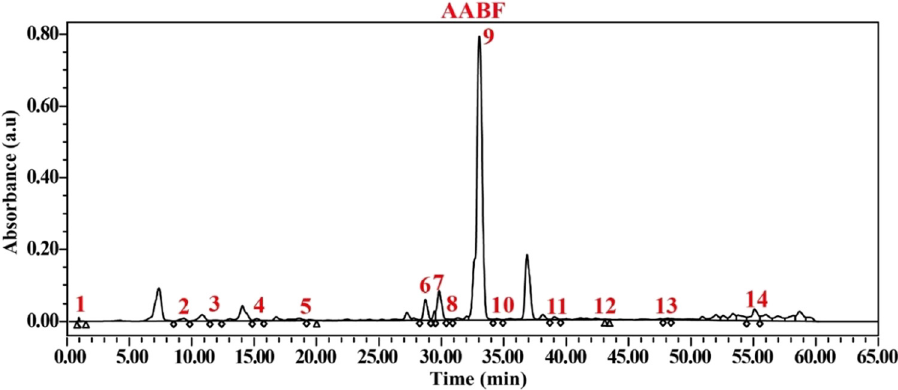
Figure 5: HPLC chromatogram of AABF. Peaks showing similar retention time to 1: gallic acid ( 1.263 min ) , 2: ca ff eic acid ( 9.366 min ) , 3: chlorogenic acid ( 11.870 min ) , 4: epicatechin ( 15.221 min ) , 5: ferulic acid ( 19.438 min ) , 6: hyperoside ( 28.723 min ) , 7: luteolin ( 29.822 min ) , 8: rutin ( 30.508 min ) , 9: fi setin ( 33.043 min ) , 10: apigenin - 7 - o - glucoside ( 34.444 min ) , 11: naringenin ( 39.054 min ) , 12: benzene - triol ( 43.104 min ) , 13: apigenin ( 47.538 min ) and 14: chrysin ( 56.962 min ) .